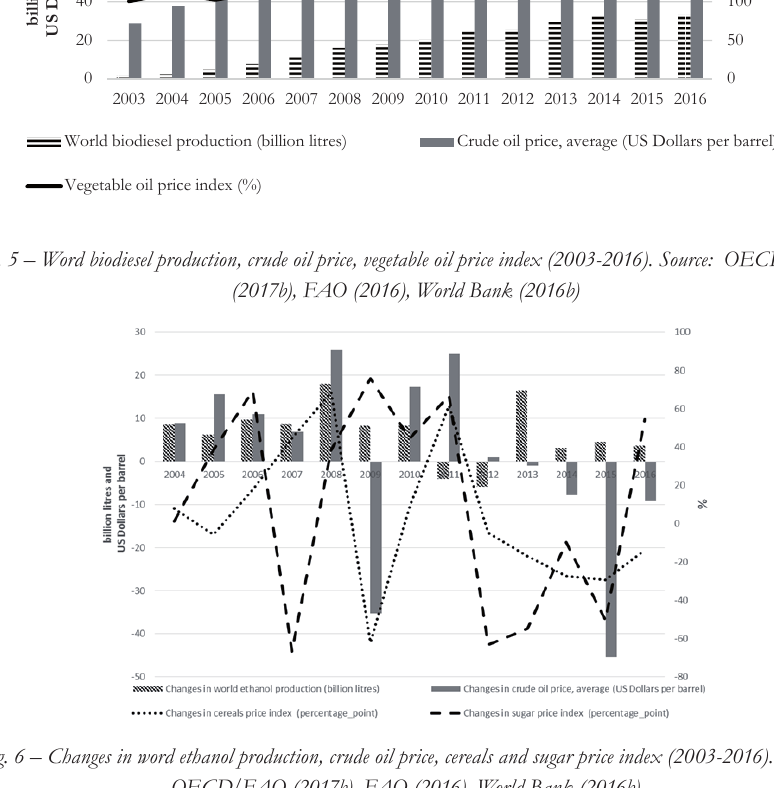
Fig. 6 – Changes in word ethanol production, crude oil price, cereals and sugar price index (2003-2016). Source: OECD/FAO (2017b), FAO (2016), World Bank